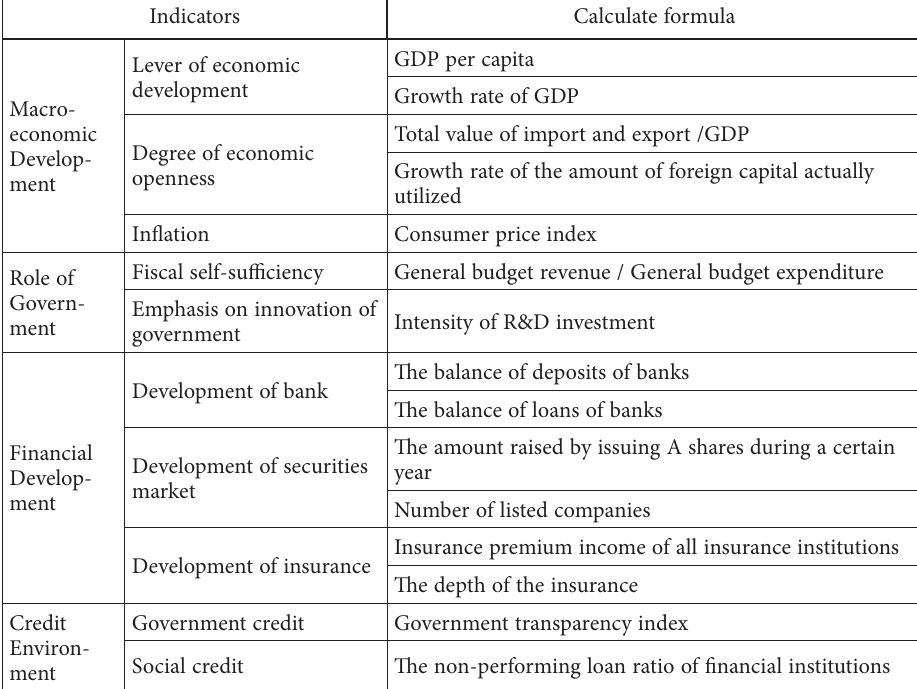
Table 1. Evaluation index system of external financing ecology Indicators Calculate